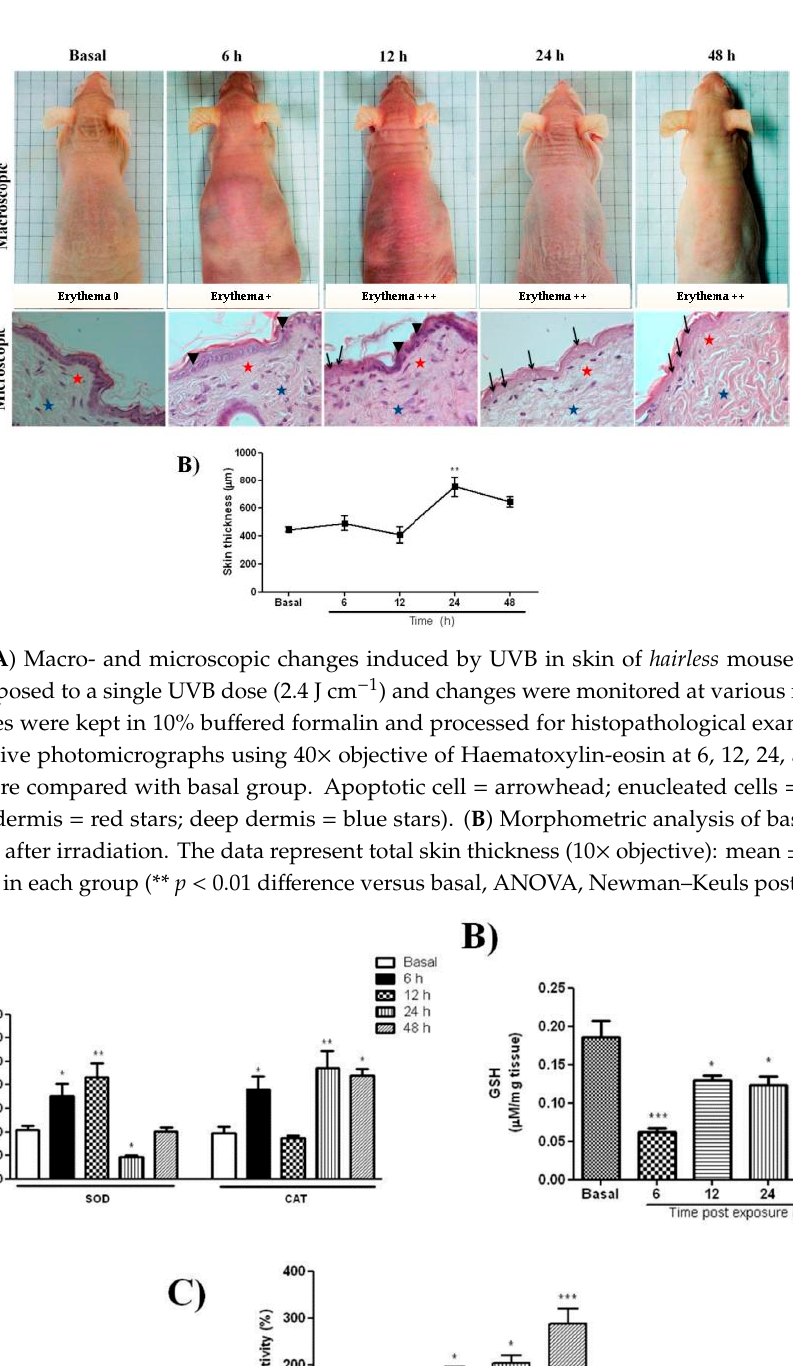
Figure 1. (A) Macro- and microscopic changes induced by UVB in skin of hairless mouse. Dorsal skin was exposed to a single UVB dose (2.4 J cm − 1 ) and changes were monitored at various intervals. Skin biopsies were kept in 10% buffered formalin and processed for histopathological examination.